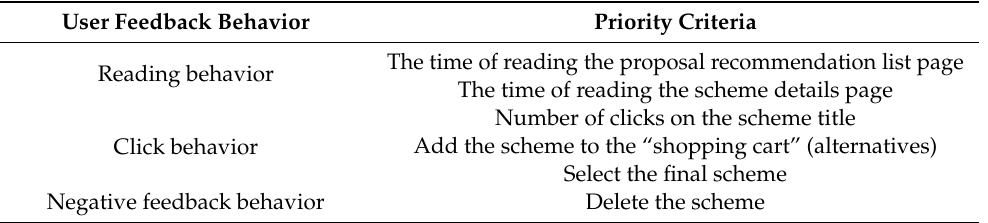
Table 3. Analysis of user